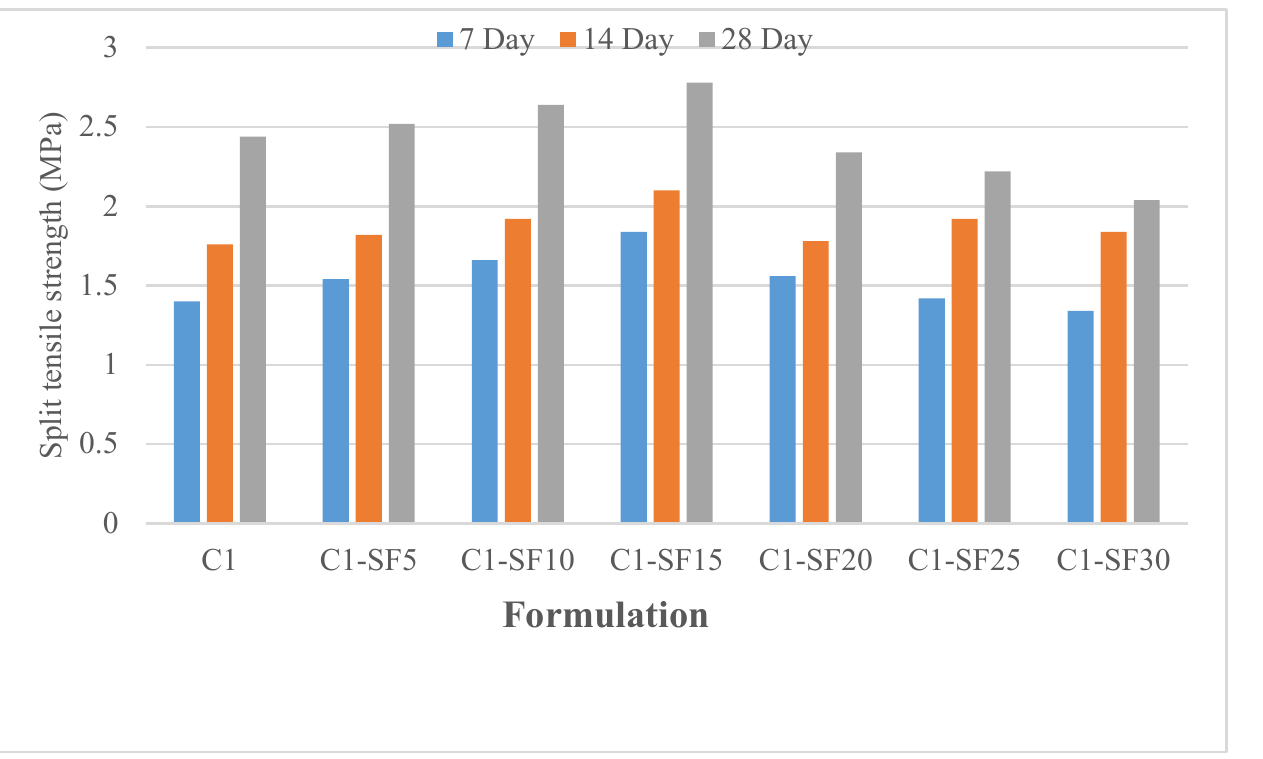
Figure 8. Split tensile strength of concrete human hair fiber with silica fume.